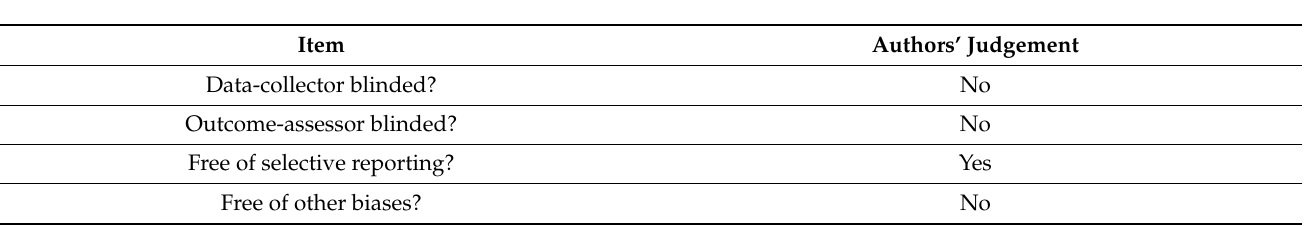
Table A12. Risk of bias.